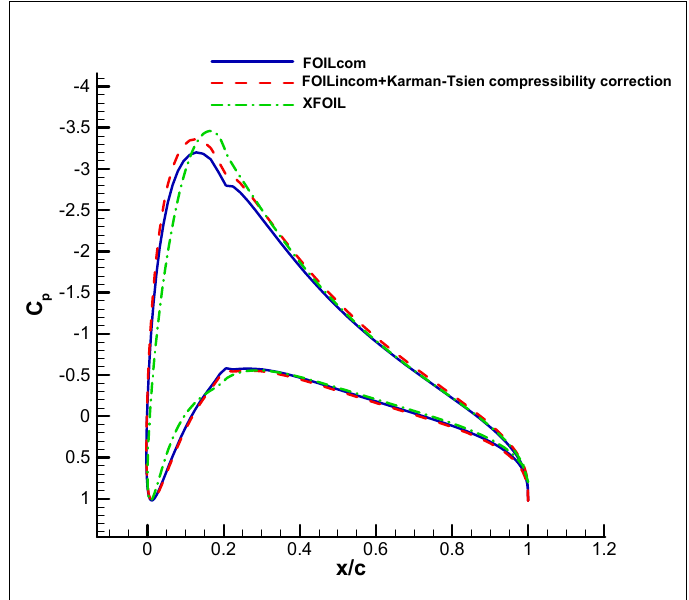
Figure 24. Comparison of surface pressure coefficient distributions for NACA 2240 airfoil ( M ∞ = 0.3, α = 6 ◦ ) using the codes FOILcom, FOILincom along with the Karman-Tsien compressibility correction, and XFOIL.